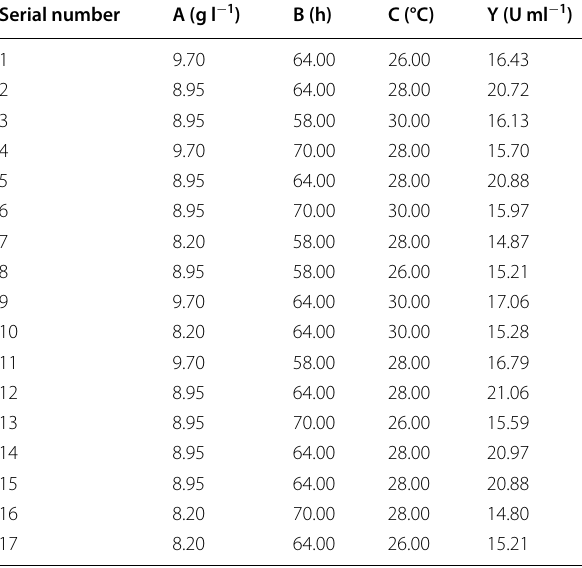
Table 5 The chitinase activities in the culture supernatants of strain TC‑1 under different combinations of three factors at different levels